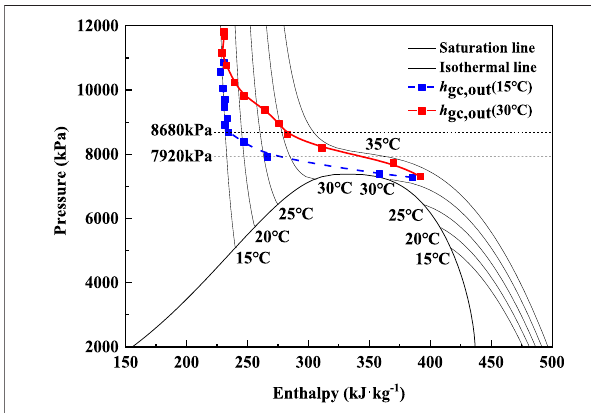
FIGURE 7 | Variation trend of the gas cooler outlet enthalpy in the P - h diagram.